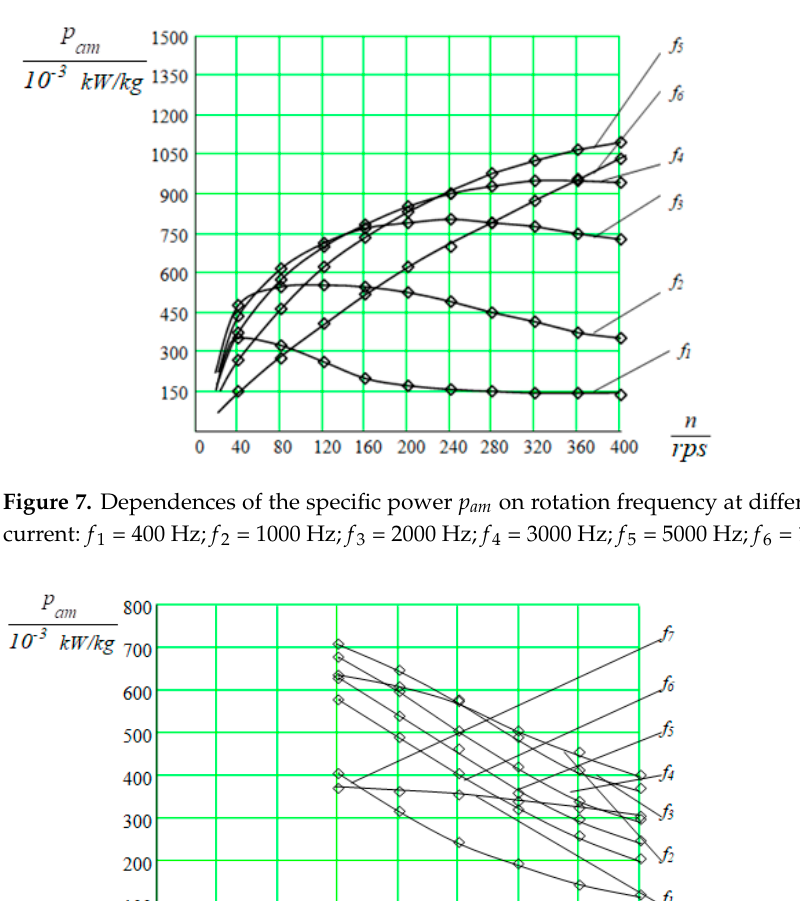
Figure 7. Dependences of the specific power p am on rotation frequency at different frequencies of current: f 1 = 400 Hz; f 2 = 1000 Hz; f 3 = 2000 Hz; f 4 = 3000 Hz; f 5 = 5000 Hz; f 6 = 10,000 Hz.